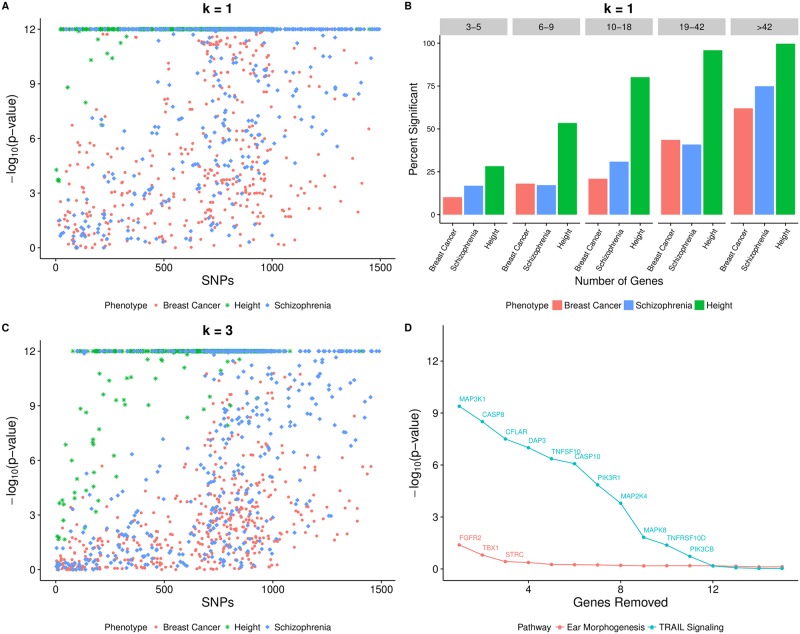
P-values of initially top-ranked pathways after removal of significant genes.(A) P-value after removal of most significant gene for pathways demonstrating p < 10−12 across each of three phenotypes. We only show the original top 500 pathways in each phenotype for sake of presentation. (B) Percentage of pathways with original significance p < 10−12 passing Bonferroni-corrected significance threshold after top significant gene is removed, stratified by quantile of gene set size. (C) P-value after removal of three most significant genes for top 500 pathways across each of three phenotypes. (D) P-value of Gene Ontology Ear Morphogenesis and Nature Pathway Interaction Database TRAIL Signaling pathways as most significant genes are removed one by one (for association with breast cancer only). P-values less than 10−12 are truncated at this value. It appears that many of the most significant height pathways are driven to significance by multiple highly associated genes, while the opposite is true for breast cancer.